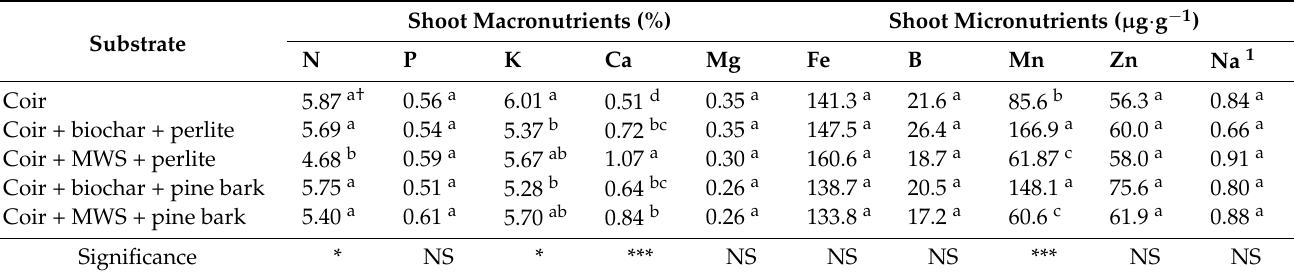
Table 2. Effects of substrates on shoot nutrient concentration.